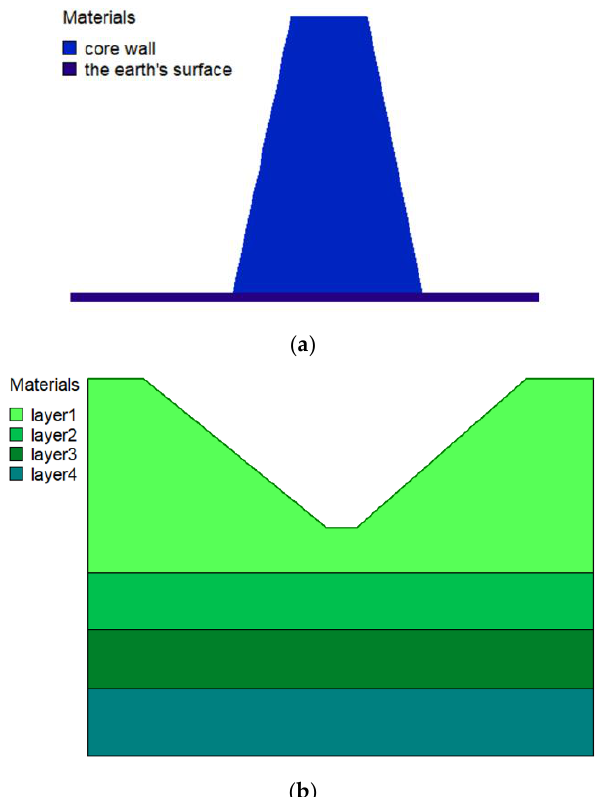
Figure 15. Simple model of the clay core dam. ( a ) Cross-section of the core. ( b ) Cross-section of the reservoir. Table 1. Each layer’s hydraulic conductivities and thicknesses .